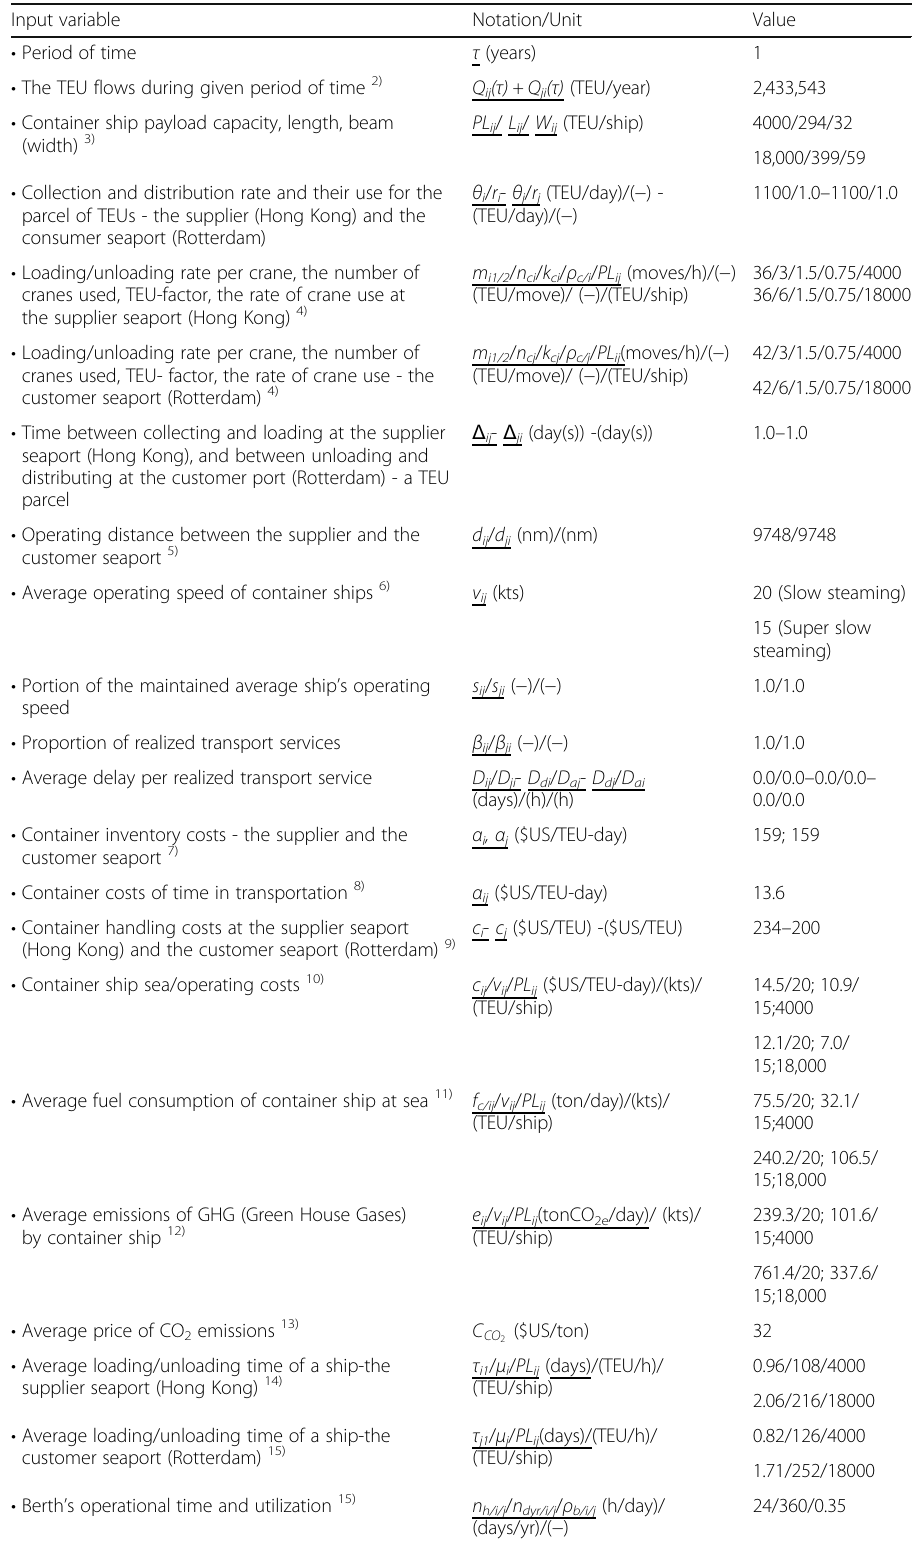
Table 1 Inputs for application of the models of indicators of performances of the given trunk line/route